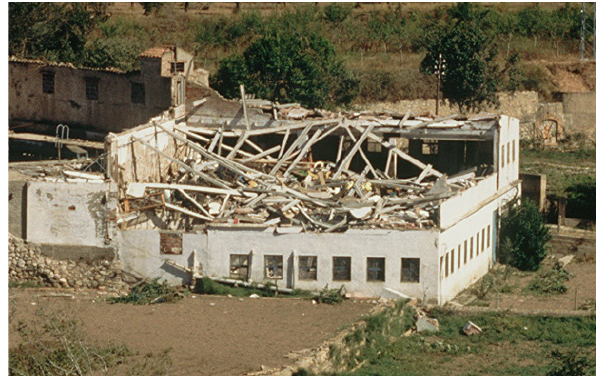
Fig. 2. Example of the impacts produced by a tornado: collapsed Figure 2. Example of the impacts produced by a tornado: collapsed farm caused by a tornado in Espluga de Francolí (Spain), on August 31, 1994 (photo © Miquel Gayà) farm caused by a tornado in Espluga de Francol´ı (Spain), on August 31, 1994 (photo © Miquel